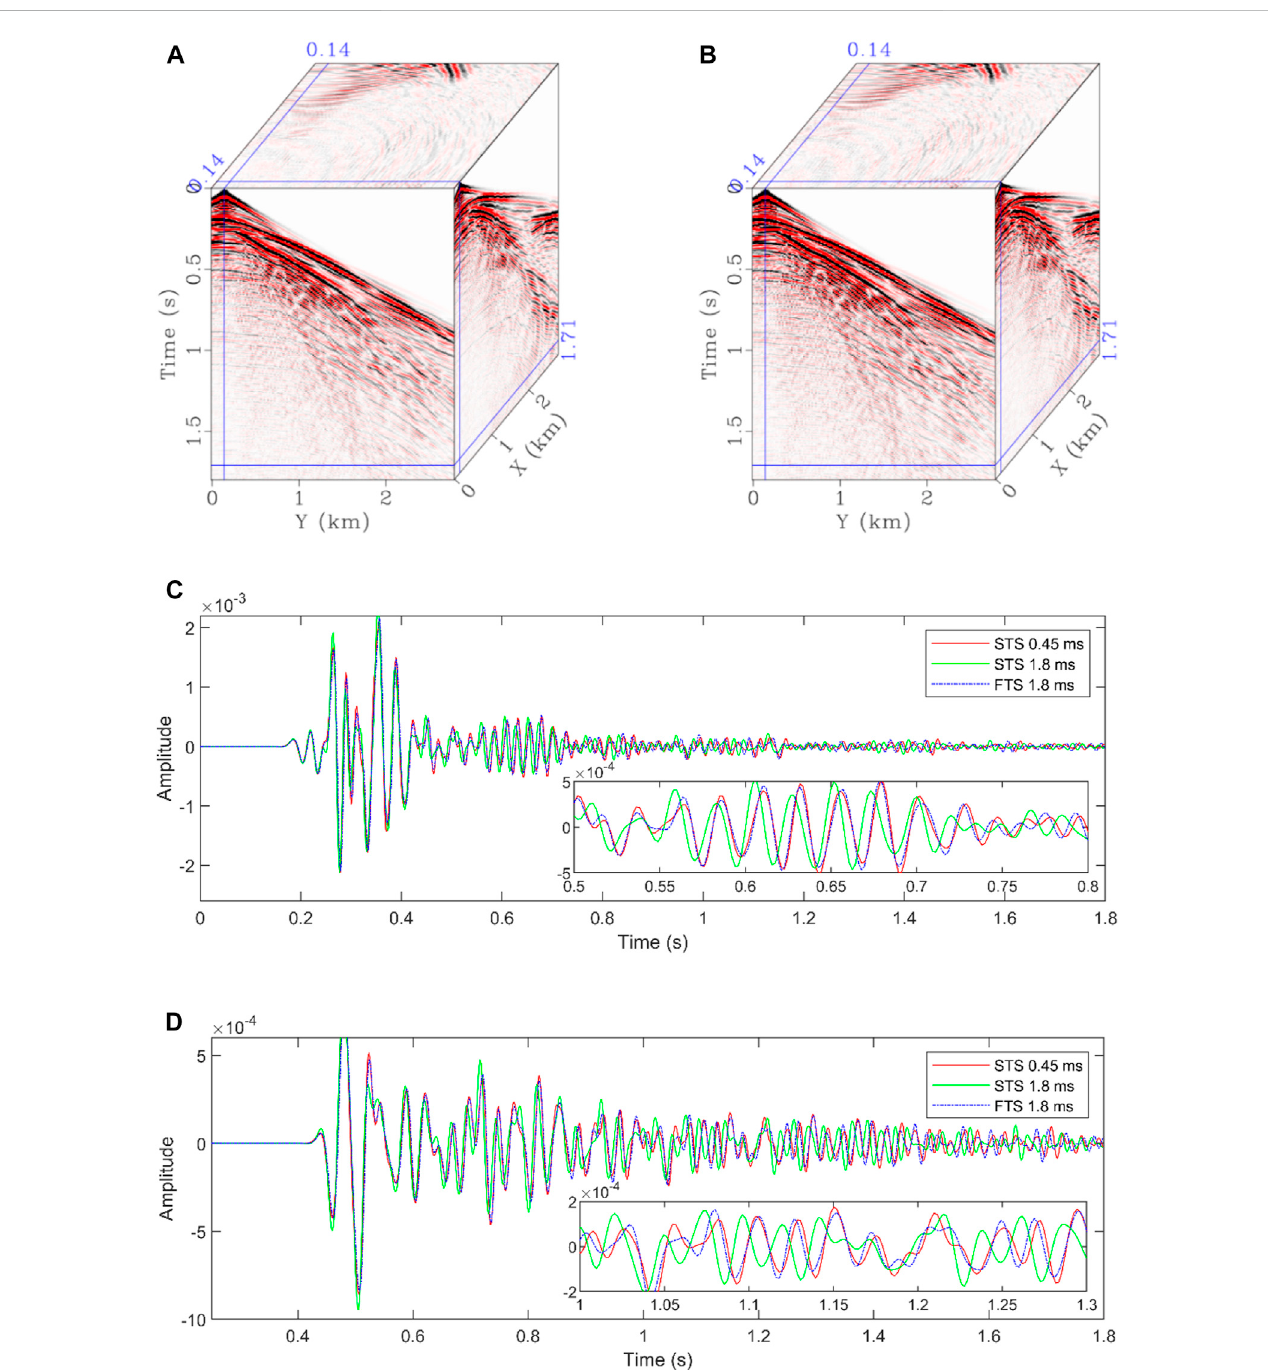
FIGURE 13 One-shot synthetic data v z generated using the (A) STS and (B) FTS methods and seismic traces v z comparisons between the results at (C) ( x , y ) = (1.0, 0.46) km and (D) ( x , y ) = (1.8, 0.46) km of the STS and the FTS methods with Δ t = 1.8 ms and STS method with Δ t = 0.45